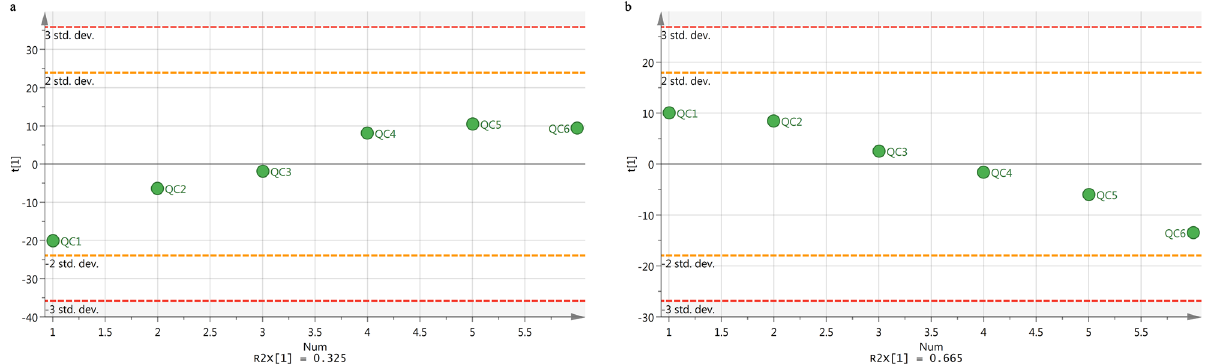
Figure 1. The first main dispersion point diagram of QC sample using LC–MS method ( a positive mode; b negative